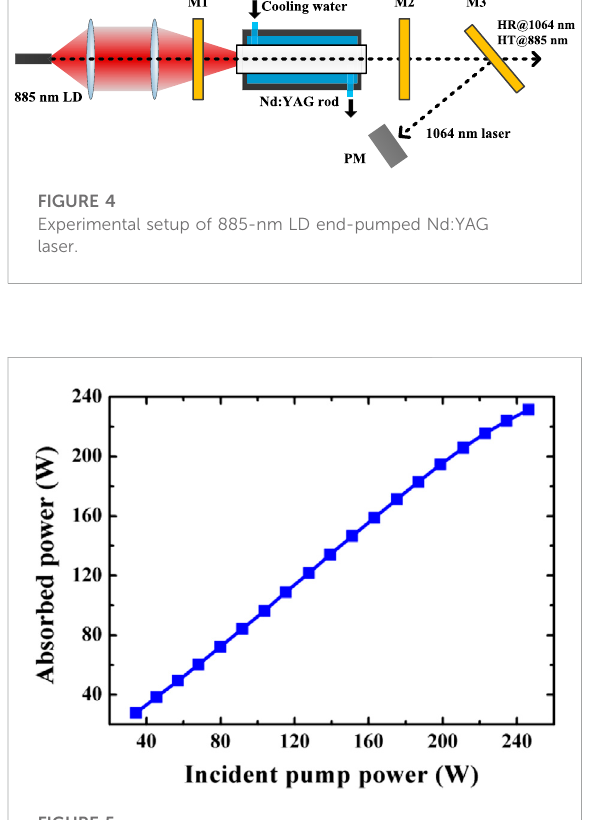
FIGURE 5 Absorbed power versus incident pump power at 885 nm.